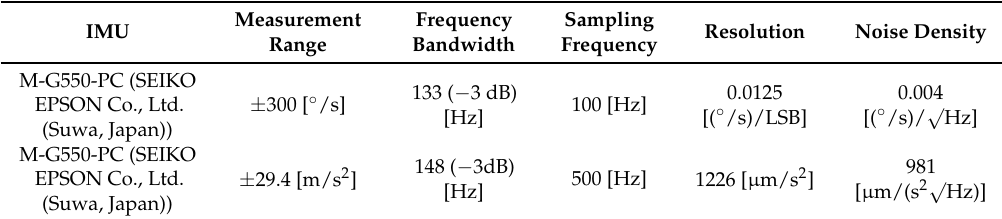
Table 2. Contact displacement gauges.